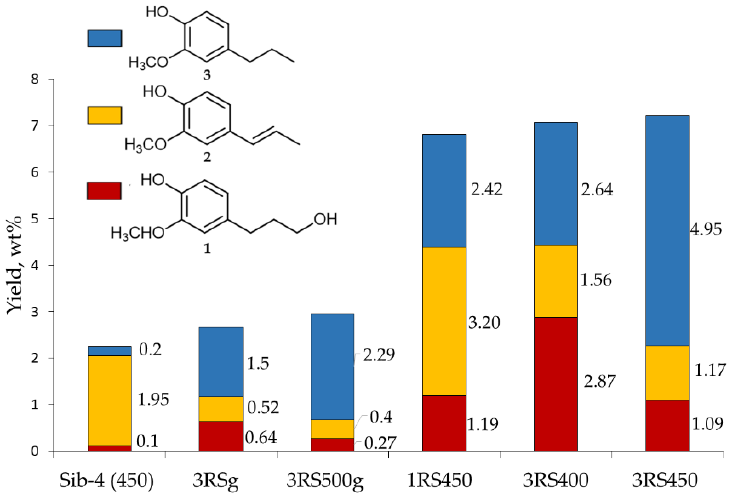
Figure 3. Yields of the methoxyphenols ( 1 ), ( 2 ), ( 3 ) for different catalysts used. Table 8. Yield and composition of monomeric methoxyphenols (wt % per lignin) in the liquid